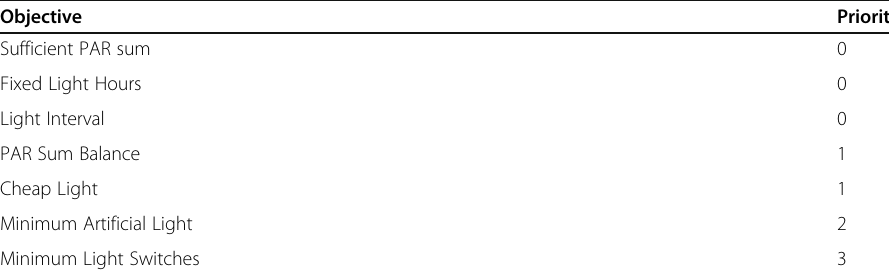
Table 5 Priority configuration in